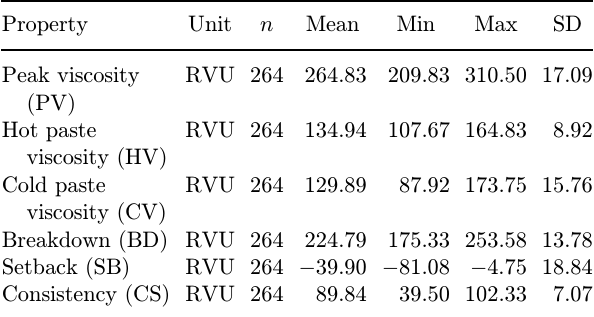
Table 1. Pasting properties of rice samples throughout six months storage period.